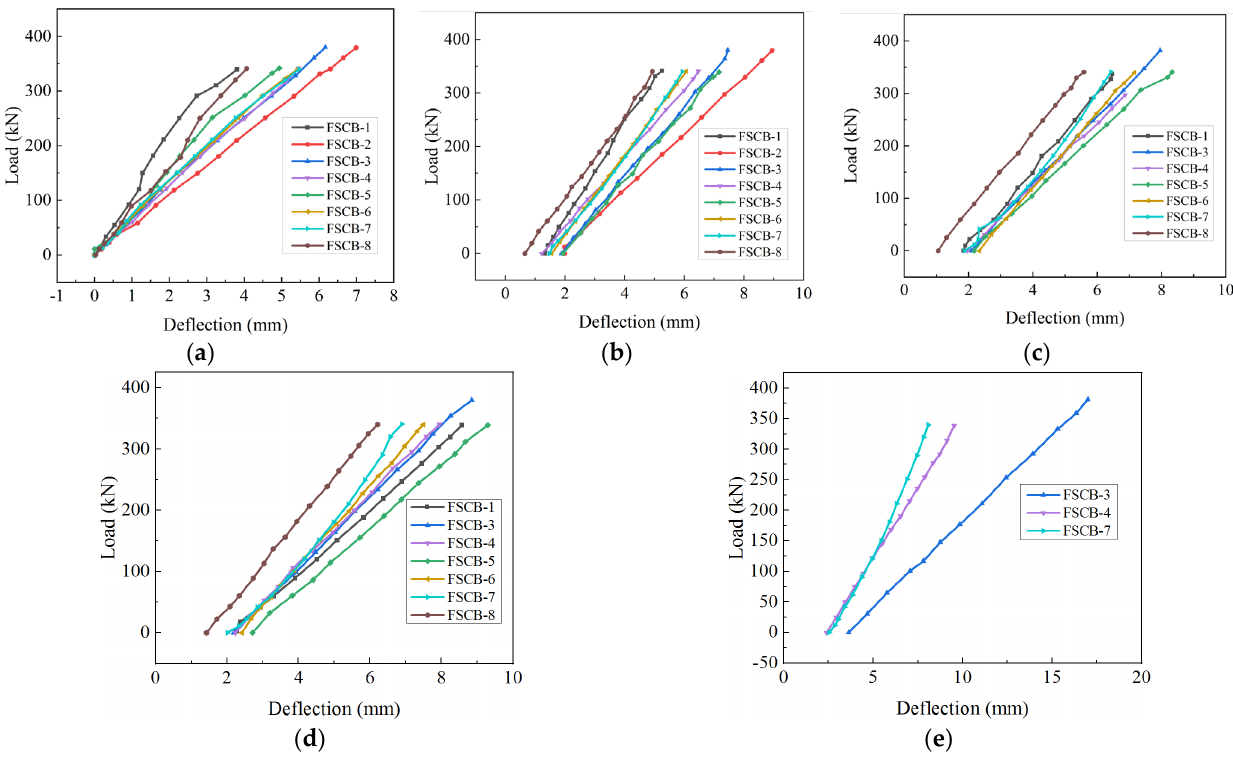
Figure 11. Load–de fl ection curves at the mid − span: ( a ) N c = 0; ( b ) N c = 5.0 × 10 5 ; ( c ) N c = 1.0 × 10 6 ; ( d ) Figure 11. Load–deflection curves at the mid-span: ( a ) N c = 0; ( b ) N c = 5.0 × 10 5 ; ( c ) N c = 1.0 × 10 6 ; N c = 1.5 × 10 6 ; ( e ) N c = 2.0 × 10 6 .